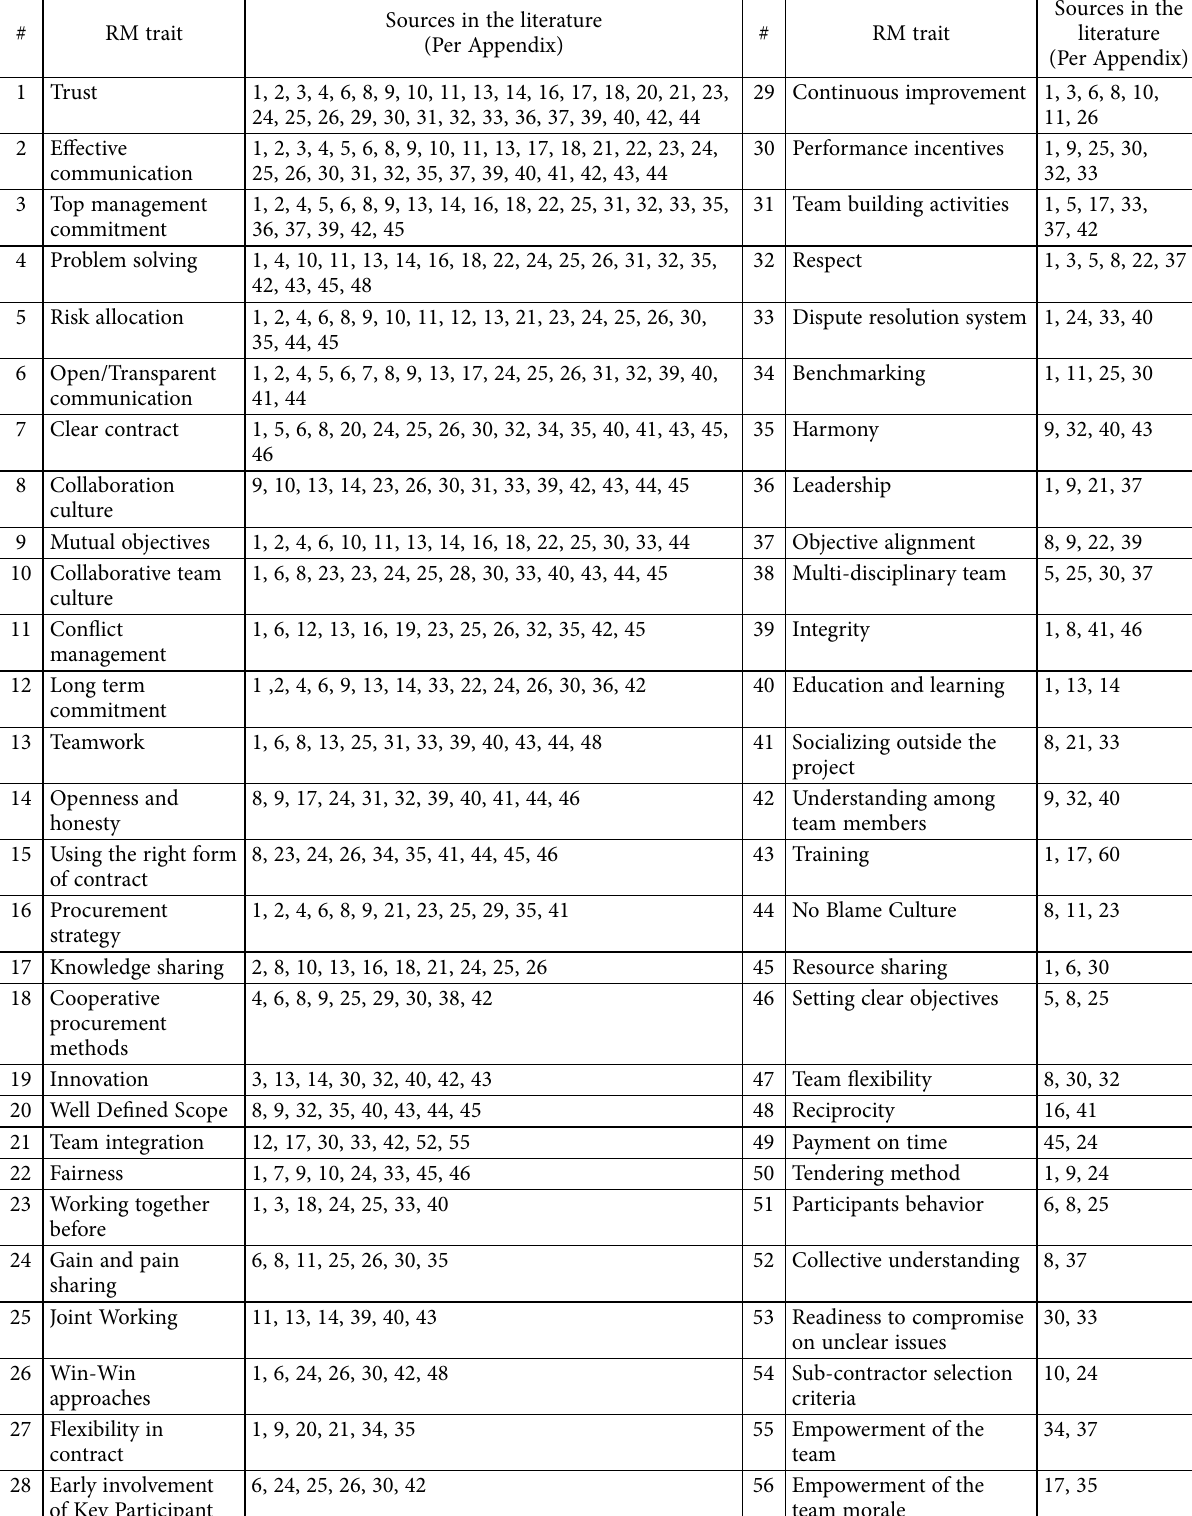
Table 1. RM associated traits extracted from the literature